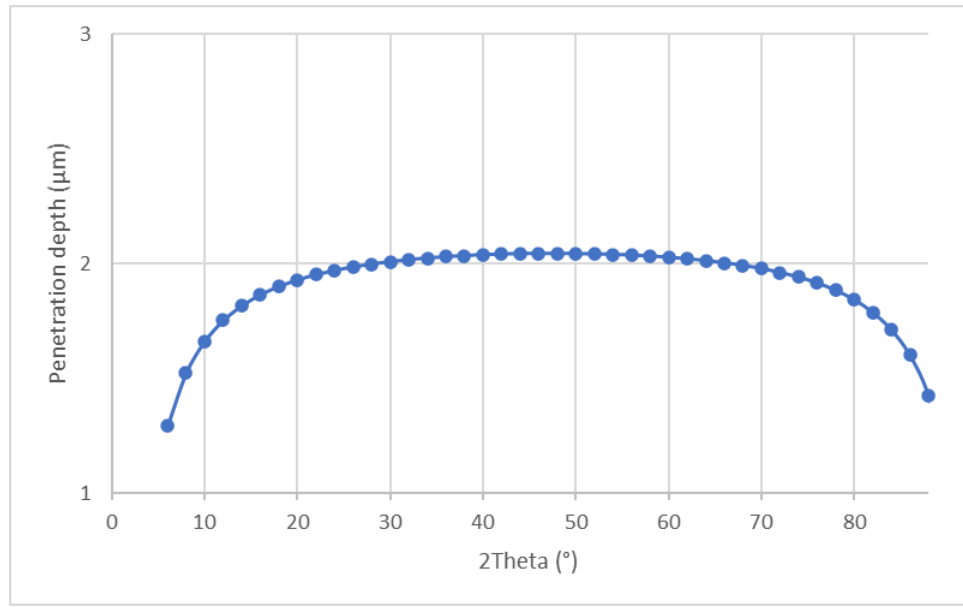
Figure 10. Penetration depth plot for grazing incidence diffraction- incident angle 5°.